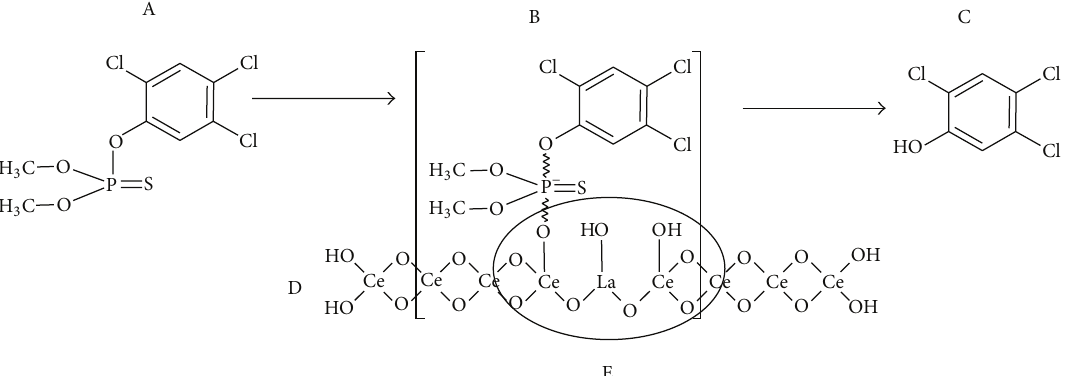
Figure 5: Degradation of fenchlorphos on cerium dioxide. A: reactant (fenchlorphos); B: transition state; C: product (2,4,5-trichlorophenol); D: cerium dioxide doped with La; E: reactive site on the sorbent surface.